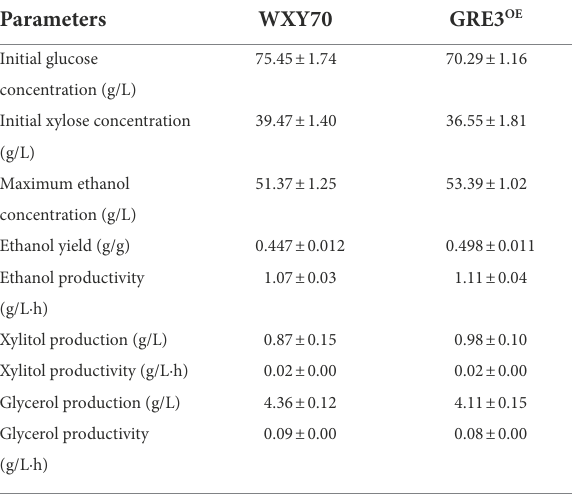
TABLE 1 Comparison of fermentation profile in simulated corn stover hydrolysate fermentation between WXY70 and GRE3 OE of the 48 h. Parameters